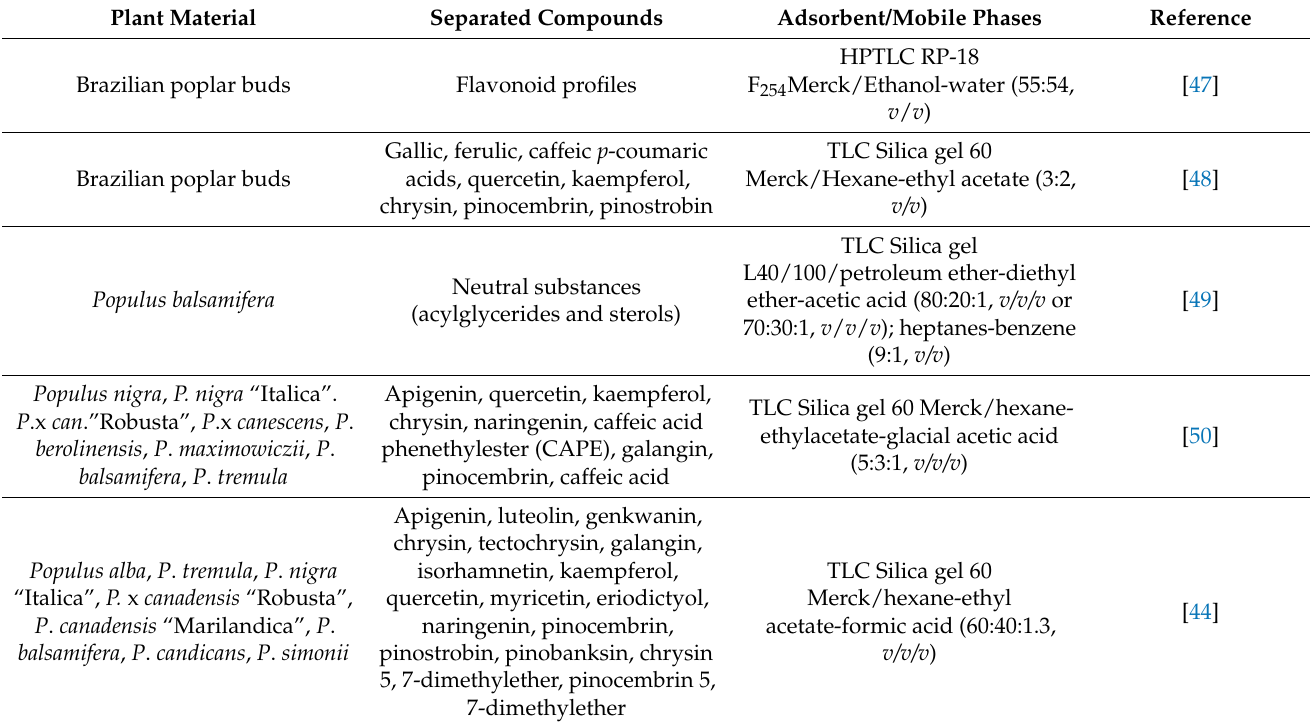
Table 1. Thin layer chromatography (TLC) analysis of phenolic compounds in extracts from different poplar species. Plant Material Separated Compounds Adsorbent/Mobile Phases Reference Flavonoid